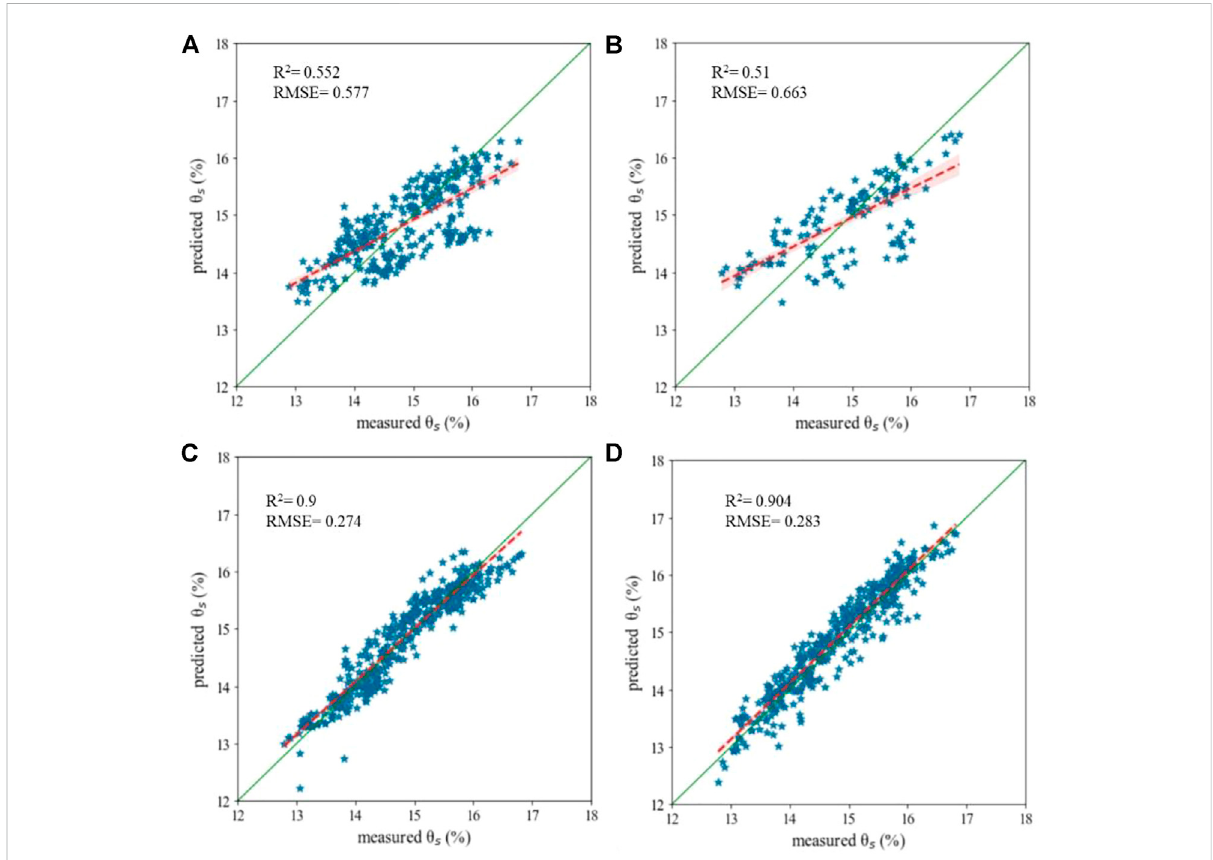
FIGURE 4 Evidence for Eq. 13 from the PLSR training stage (A) , testing stage (B) , and ANN analyses before excluding the secondary contributors (C) and after excluding the secondary contributors (D) . Note: θ s is the soil volumetric water content at 0 – 5 cm. All other environmental variables are considered potential contributors to θ s